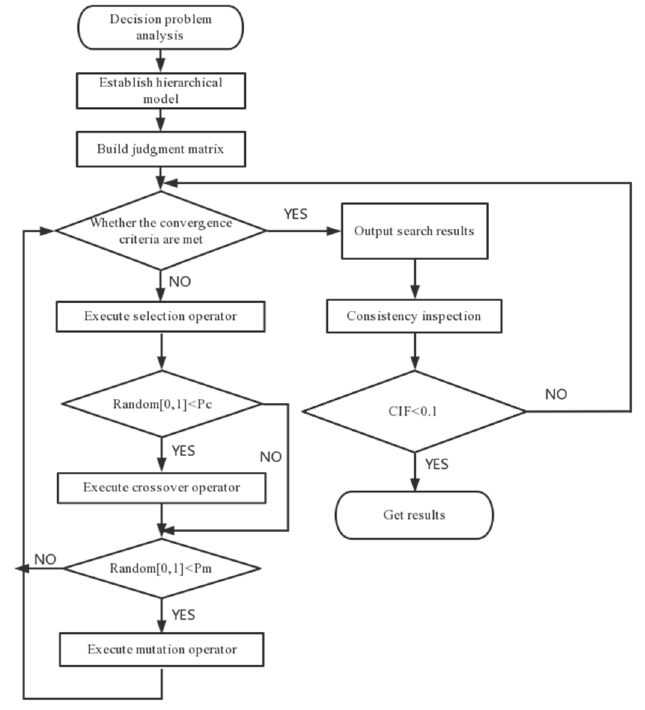
Figure 2. AHP-GA Flow Chart.